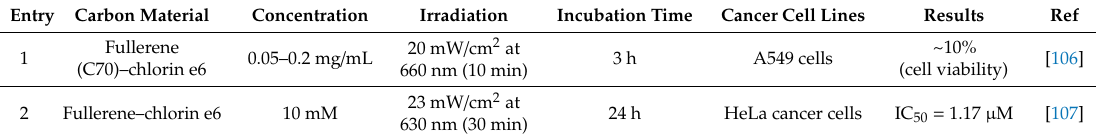
Table 3. Parameters used for chlorin-based photosensitizers immobilized on fullerenes as a photosensitizer against cancer.